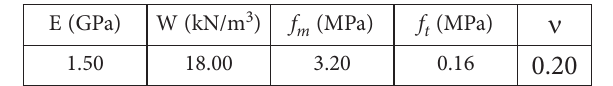
Table 1. Mechanical properties of the clay brick masonries